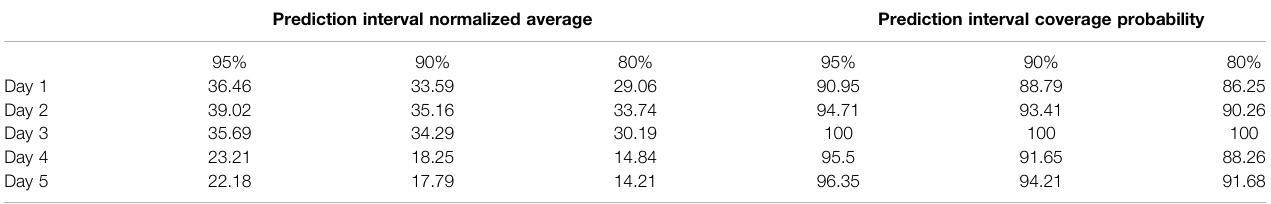
TABLE 5 | Indicator results based on generalized error distribution.